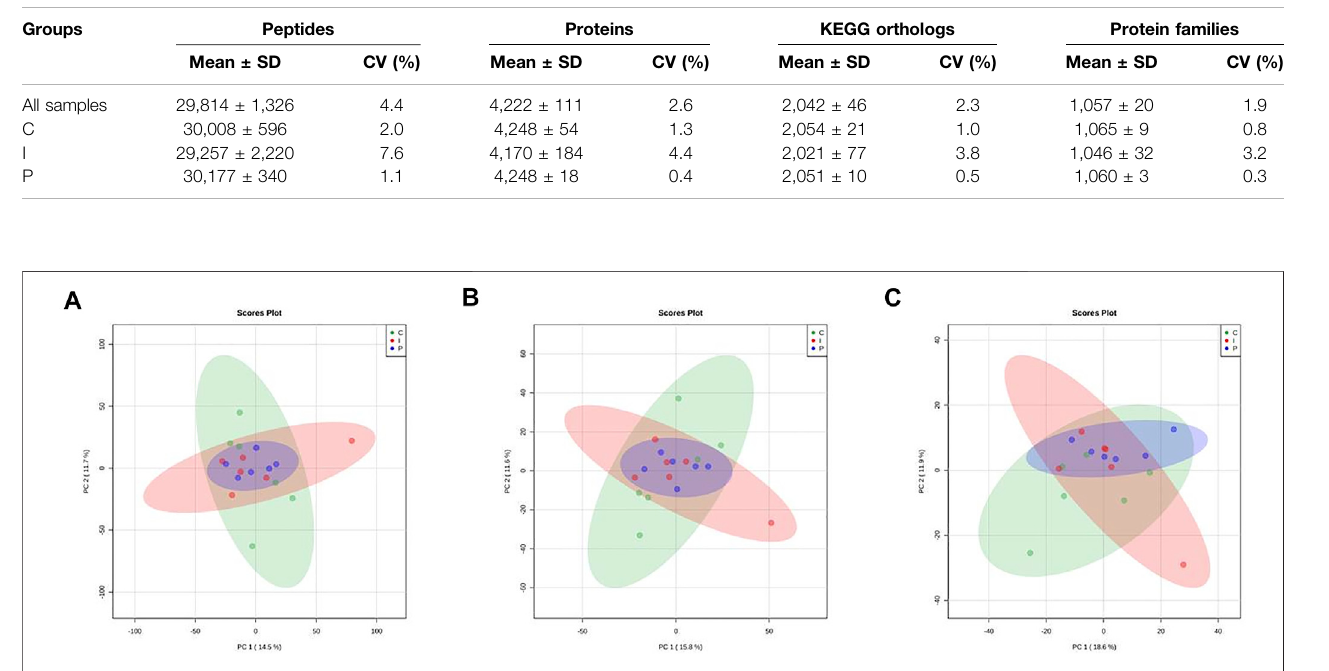
FIGURE2 | Principal component analysis (PCA) scores plots related toquantitative data ofproteins (A) KEGG orthologs (B) and protein families (C) obtained from liverofrainbowtroutsubjectedtodifferentfeedtreatment(C:controldiet,green;I:insectmealdiet,red;P:poultryby-products mealdiet,blue).Coloredellipsesdescribe the T 2 -Hotelling 95% con fi dence intervals of each dietary